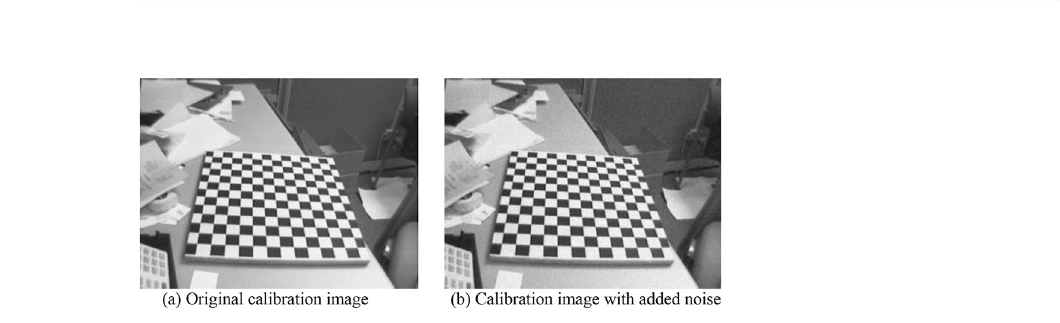
Table 1. Calculation results of the method in this paper.